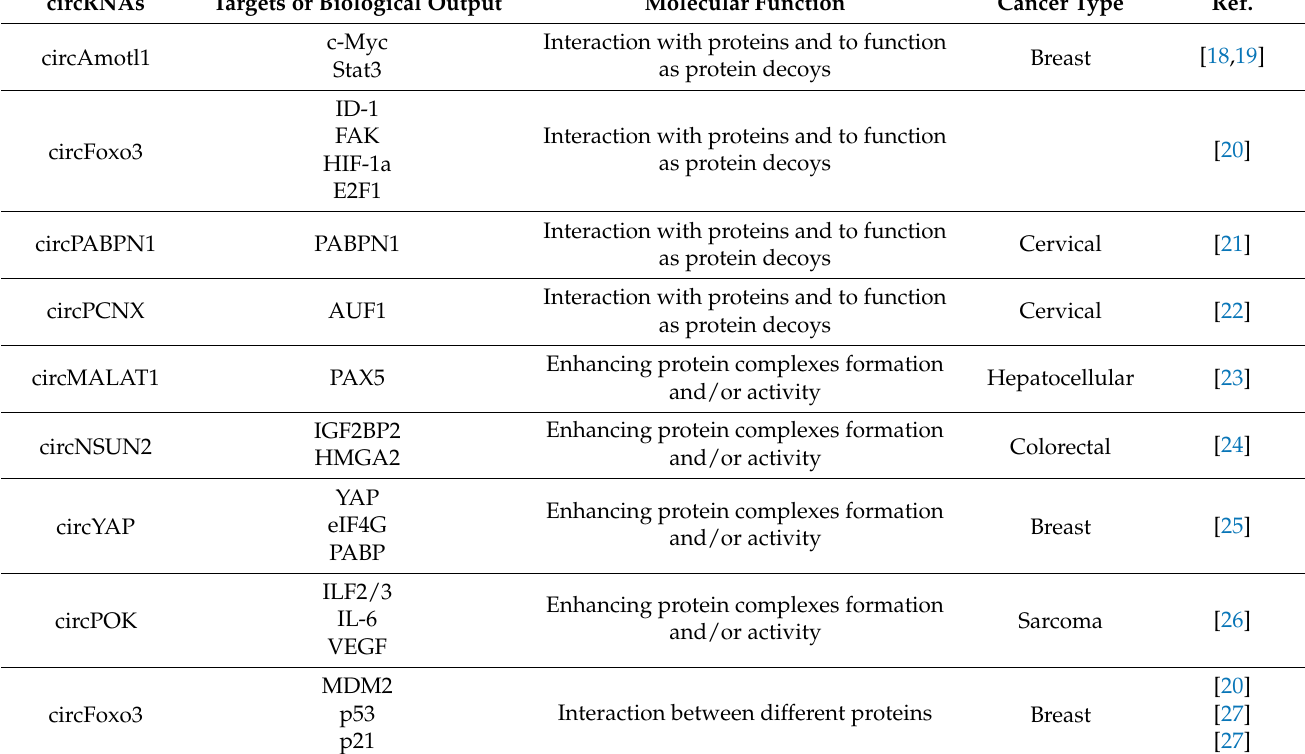
Table 1. Summary of oncogenic and tumor suppressors reviewed